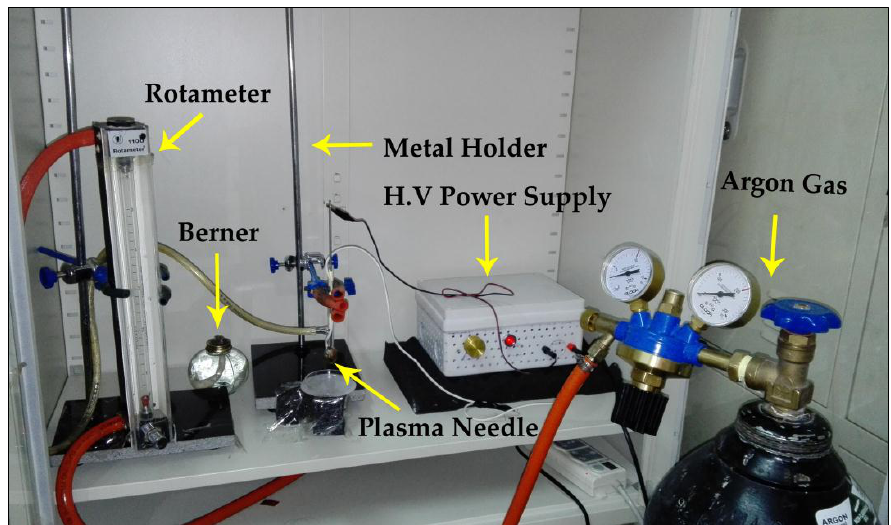
Fig. 2: Image of non-thermal plasma needle system.